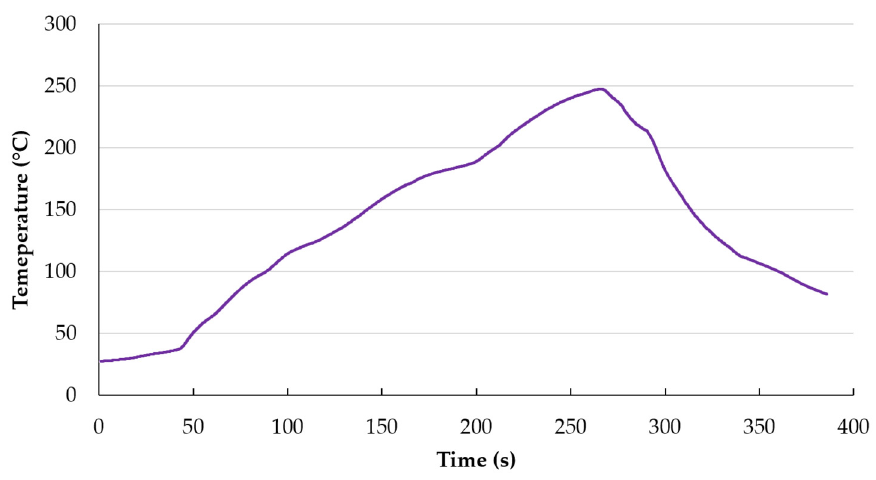
Figure 5. Temperature profile achieved for reflow in the oven Mistral 260.